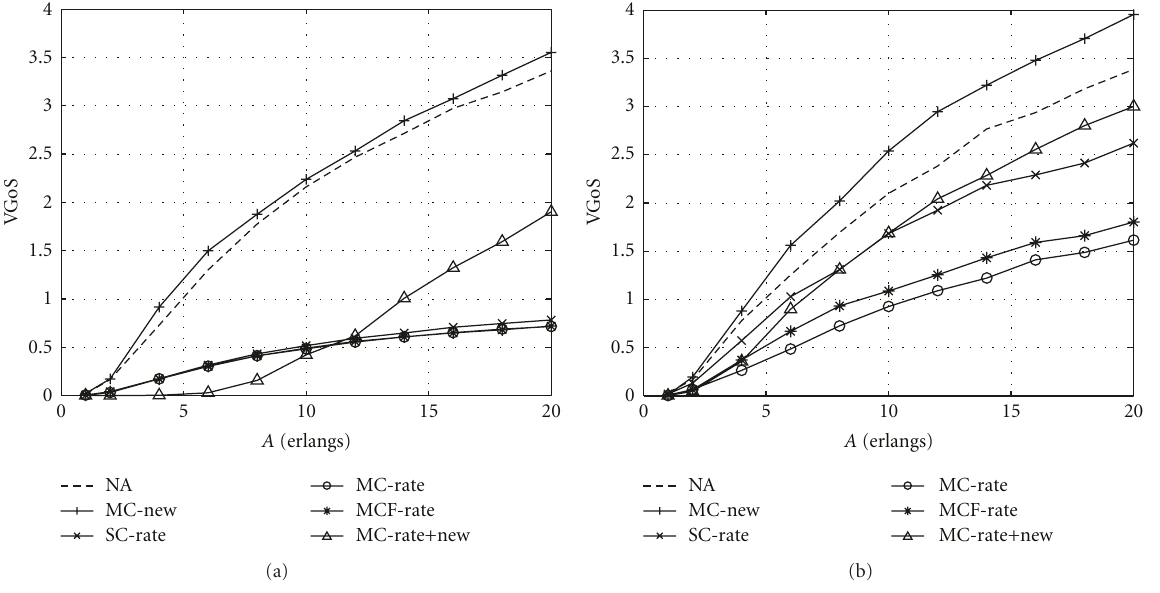
Figure 4: VGoS versus o ff ered tra ffi c for (a) 100% node participation, (b) 40% node